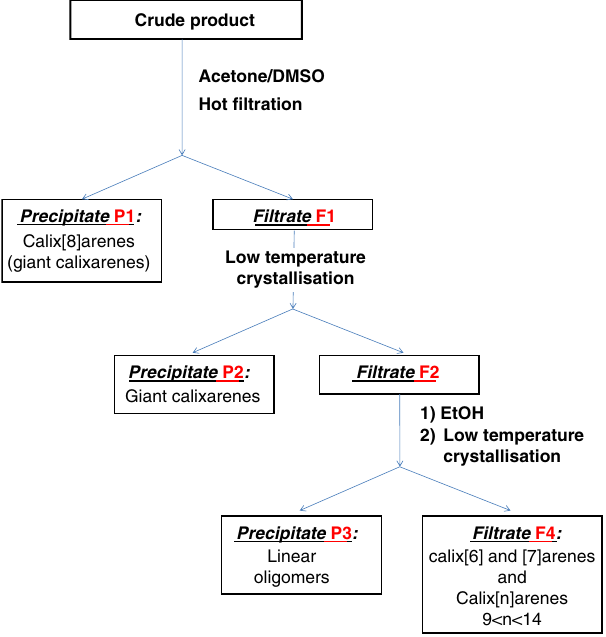
Fig. 3 DMSO/acetone-based puri fi cation process of giant calixarenes. The different puri fi cation fractions are highlighted in